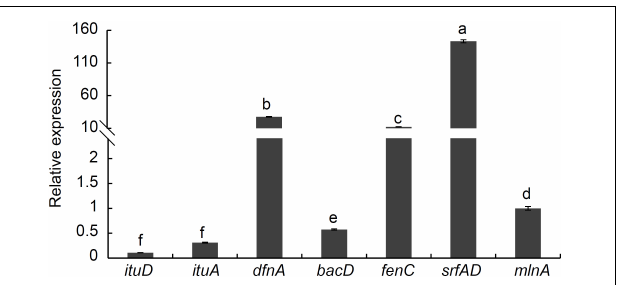
FIGURE 8 | Analysis of antibiotic biosynthesis genes expression from B. velezensis strain P2-1 using qRT-PCR. Relative expression was determined by comparing mlnA , arbitrarily set to 1. Each data represents the mean ± SD of three biological replicates at each time point. Different letters indicate significant differences between different treatments according to Student’s t -test ( P <